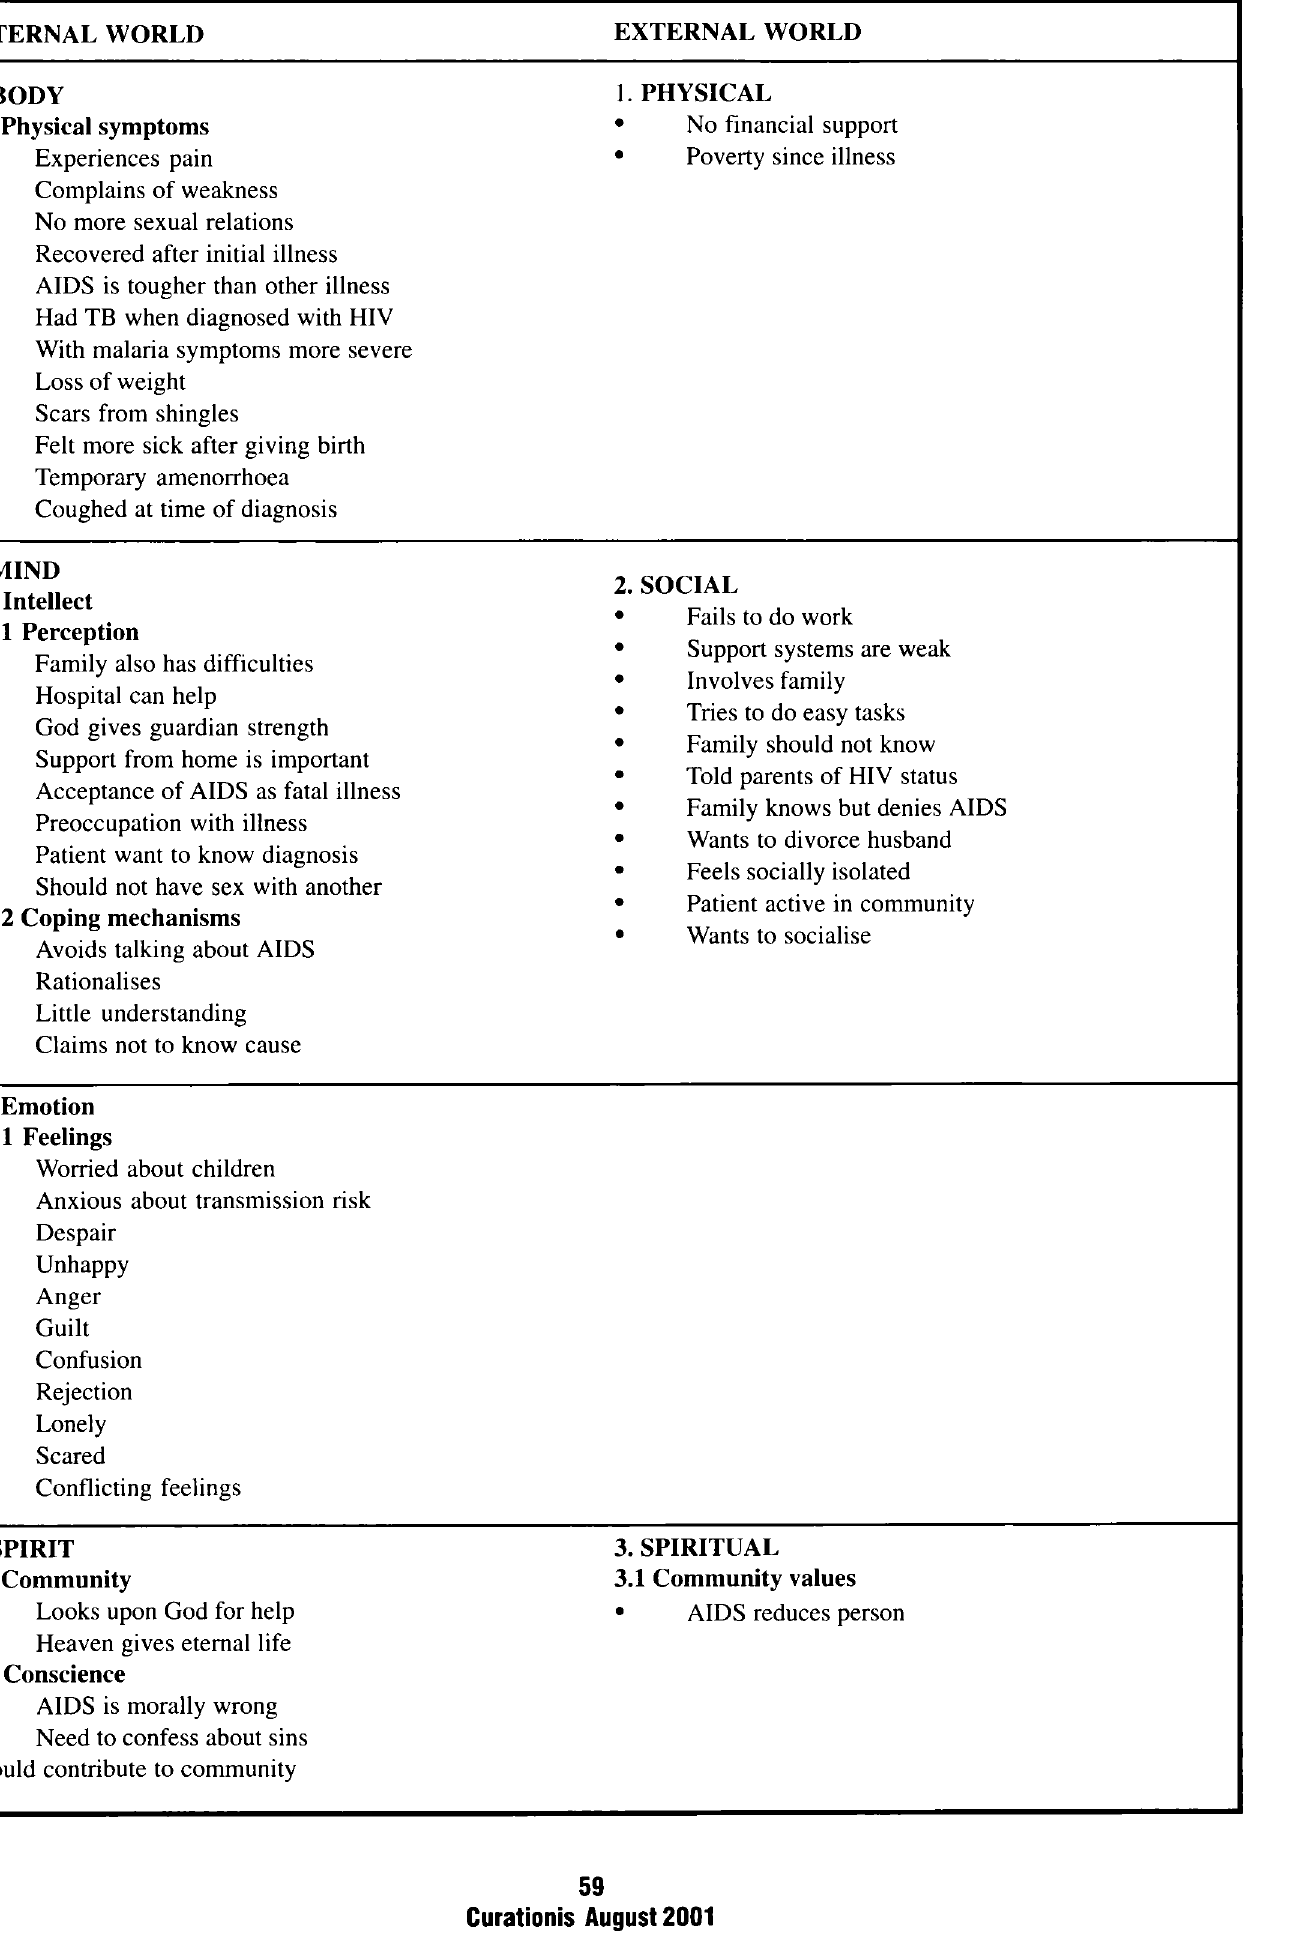
Overview of all responses given by